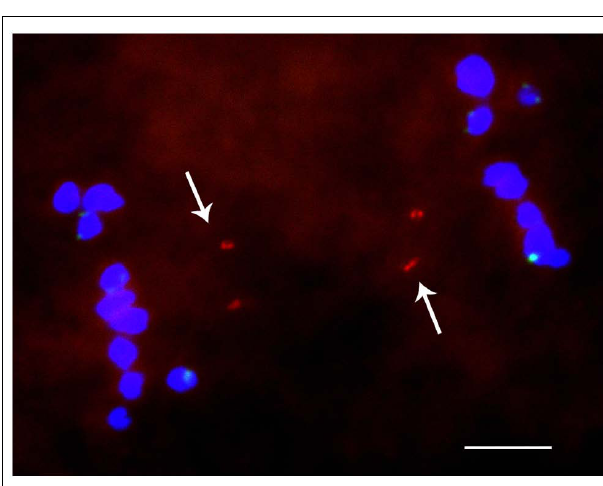
FIGURE 5 | Cytological analysis of two copies of a minichromosome. ZmBs is labeled in red; knob heterochromatin is labeled in green. Arrows indicate that the separation of sister chromatids at anaphase I. Bars = 10 μ m.